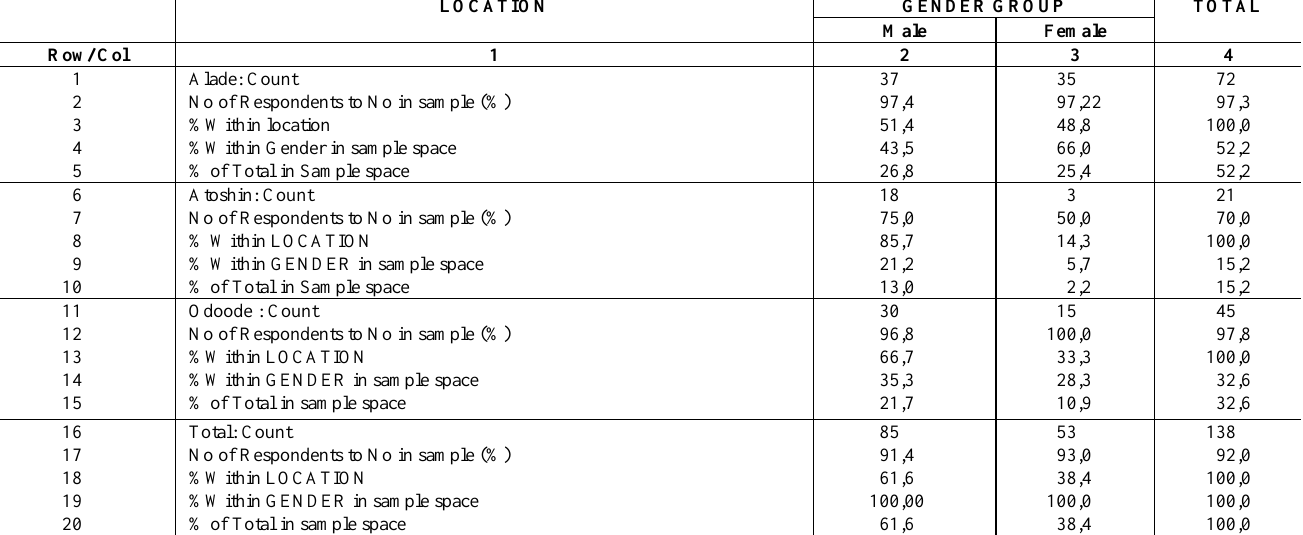
Table 3: Respondent marketers by gender and location, Idanre, Ondo State, Nigeria: 2000/2001 season